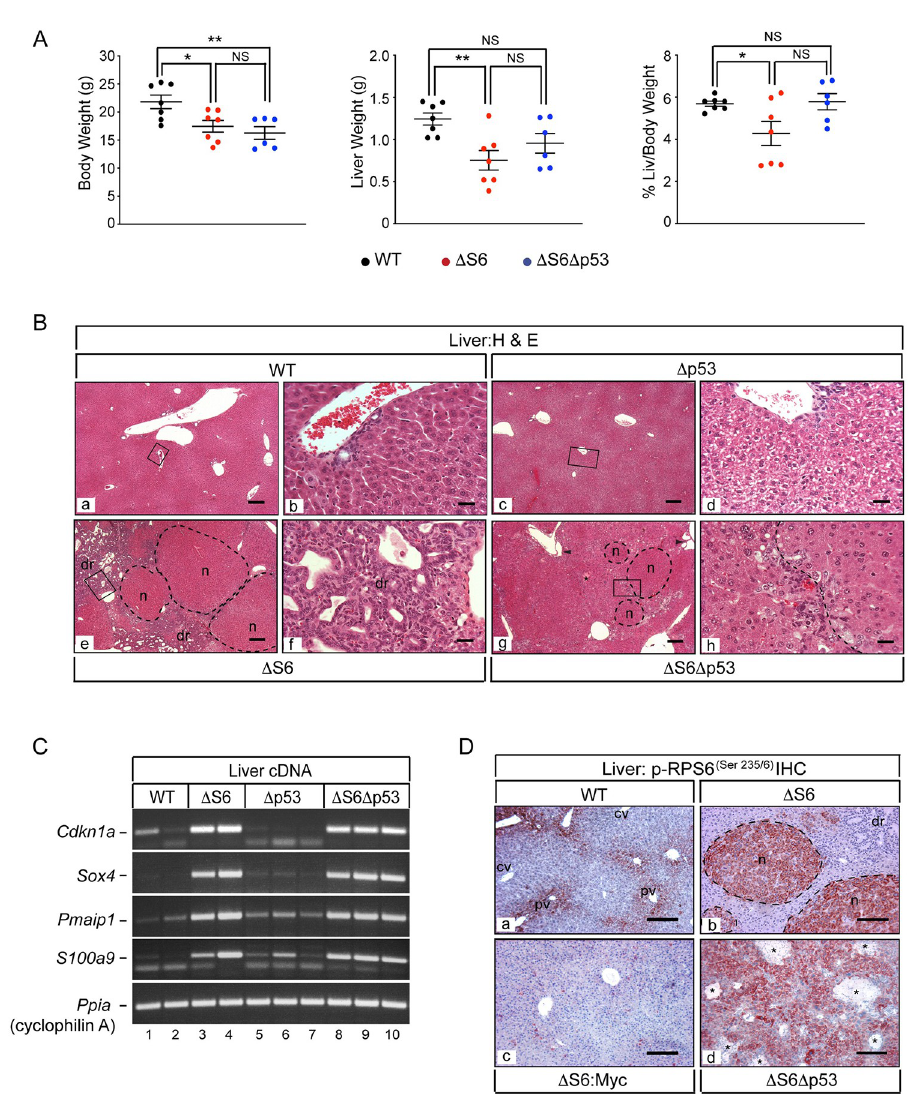
Fig 9. Loss of p53 does not rescue the Δ S6-associated growth defect or hepatic dysfunction. (A) Graphs of body weights, liver weights and % liver/body weights of 32–40 day old WT, Δ S6 and Δ S6 Δ p53 mice. P values: � P � .05, �� P � .01. NS; not significant (2-tailed unpaired Student’s t -test). (B) Photomicrographs of H&E stained sections of livers from 4–5 week old WT, Δ S6, Δ p53 and Δ S6 Δ p53 mice showing normal architecture and the presence of bile ducts in WT (a, b) and Δ p53 (c, d) livers and well defined nodules and a prominent dr in the Δ S6 liver (e, f). Note moderate hepatocyte vacuolation in Δ p53 livers (d). In the Δ S6 Δ p53 liver (g, h), nodules are present but are less defined due to the absence of a prominent dr which accentuates nodular boundaries in Δ S6 livers. Normal bile ducts are absent and biliary malformations are evident (arrow heads). Original magnifications; a, c, e and g (x 31.25; scale bars 100 μ ), b, d, f and h (x 250; scale bars 25 μ ). (C) Ethidium stained gels of sq-PCR performed on cDNA prepared from individual WT, Δ S6, Δ p53 and Δ S6 Δ p53 livers. Note that loss of p53 fails to normalize the expression of any of the mRNAs induced in Δ S6 livers including p21/Cdkn1a . (D) IHC of livers of WT (a), Δ S6 (b), Δ S6:c-Myc (c) and Δ S6 Δ p53 (d) mice with a phospho-RPS6 (Ser235/6) -specific antibody showing that mTOR activation in Δ S6 livers is suppressed by overexpression of c-Myc, but not by loss of p53. Original magnifications; a, c, d (x62.5; scale bars, 100 μ ), b (x125; scale bar 50 μ ). (AEC chromagen, red; hematoxylin counterstain,